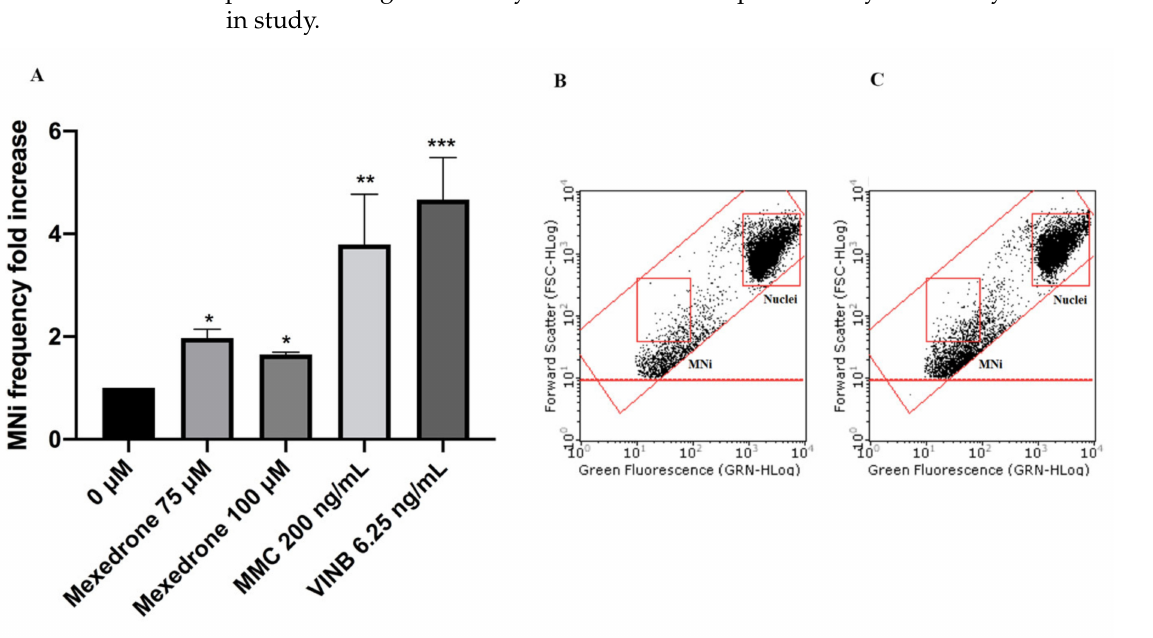
Figure 3. MNi frequency fold increase on TK6 cells after 26 h treatment with mexedrone at the indicated concentrations compared to the negative control [0 µ M] and to positive controls [MMC and VINB] ( A ), plot of nuclei and MNi in the negative control ( B ) and in 100 µ M mexedrone -treated cultures ( C ). Each bar represents the mean ± SEM of five independent experiments. Data were analyzed using repeated ANOVA followed by Bonferroni post-test. * p < 0.05 vs. 0 µ M; ** p < 0.01 vs. 0 µ M; *** p < 0.001 vs. 0 µ